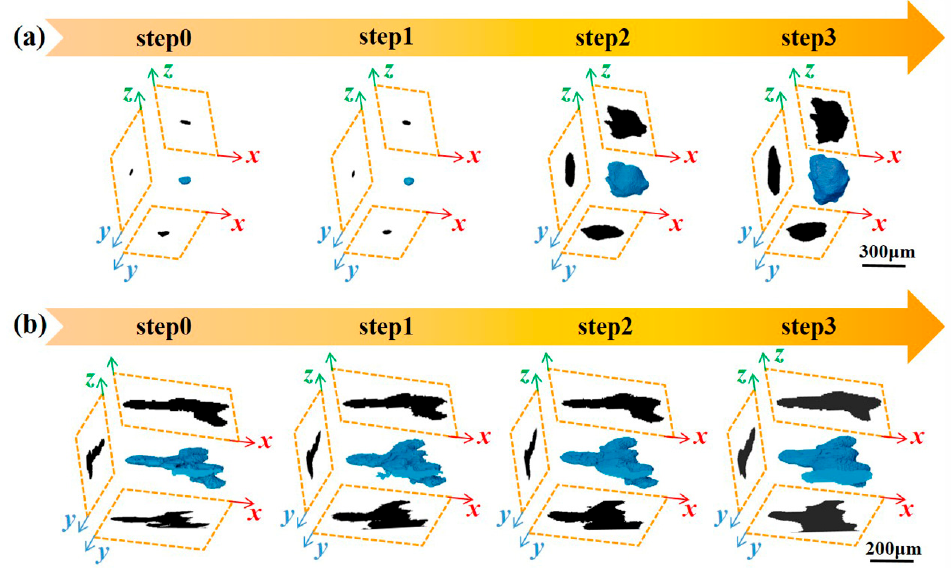
Figure 9. Three dimensional morphology of the critical defects of ( a ) Specimen 400 and ( b ) Specimen 1000 at different loading steps.